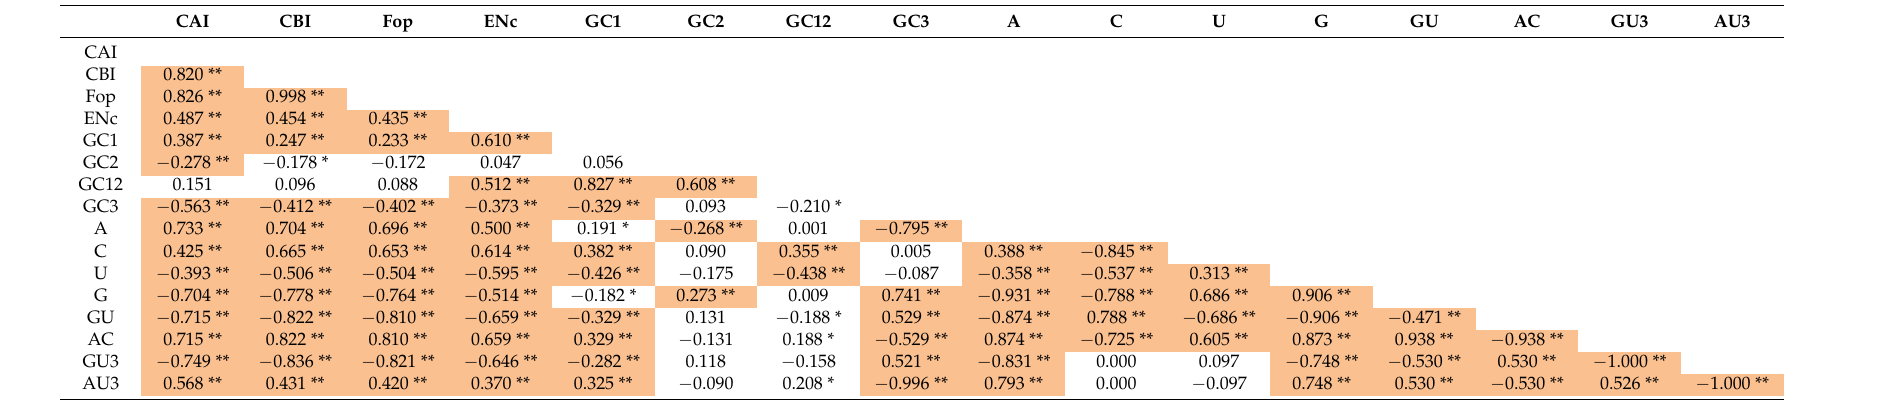
Table 2. Correlation analysis among different nucleotides compositions of